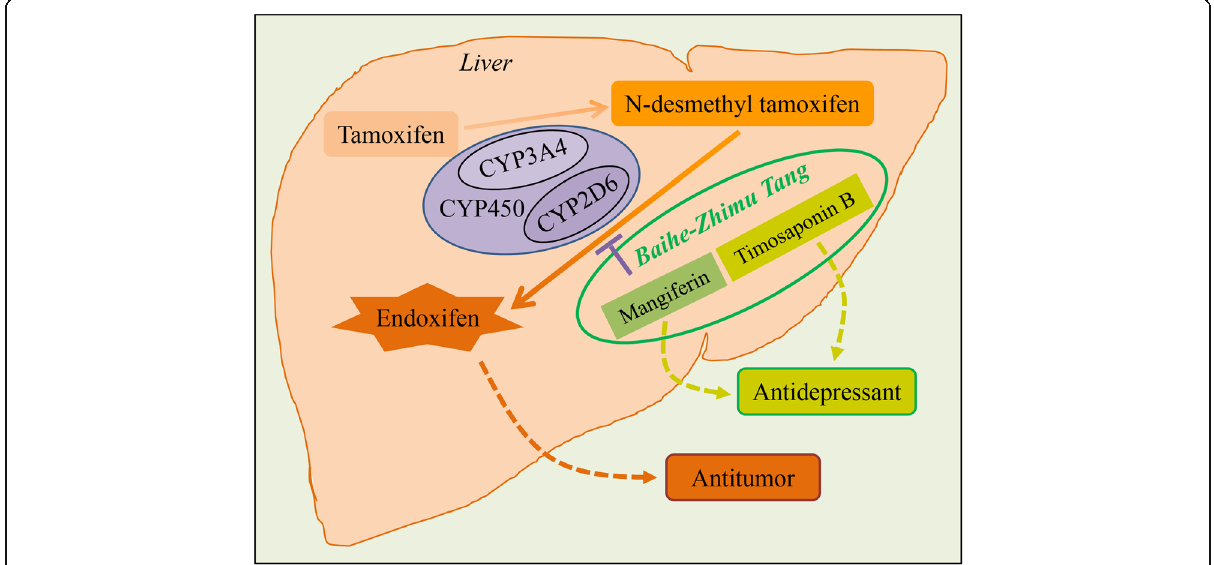
Fig. 6 Diagram of the drug-drug interaction between BZ formula and tamoxifen in breast cancer and depression. Tamoxifen is primarily metabolized to N-desmethyltamoxifen in a process mediated by CYP3A4 [3], followed by CYP2D6-mediated oxidation to 4-hydroxy-N- desmethyltamoxifen (endoxifen) [4]. Mangiferin but not timosaponin BII, derived from BZ formula, inhibited P450 activity in rat liver microsomes. BZ formula attenuated the efficacy of tamoxifen against breast cancer. However, tamoxifen did not affect the antidepressant activity of BZ formula or timosaponins, but did inhibit mangiferin. In summary, BZ formula attenuated the efficacy of tamoxifen against breast cancer through CYP450 enzyme